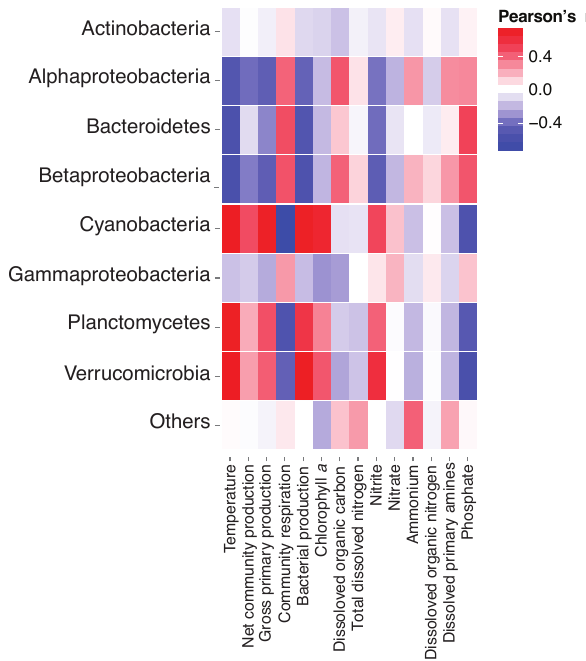
Figure 9. Correlations between shifts in relative abundances of ma- jor bacterial groups at phyla/class level and environmental factors and metabolic activity. The level of correlation is estimated from Pearson’s r , where blue and red indicate negative and positive cor- relations,